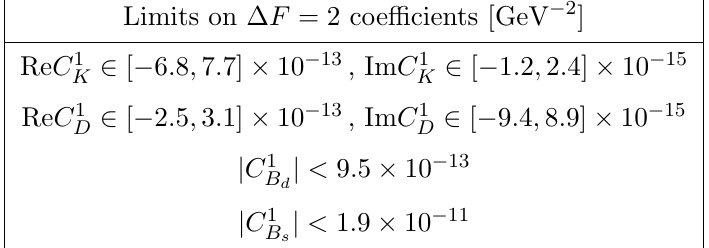
The SM expressions of branching fractions can be found in [91]. Using the values (B.18){ (B.21), we